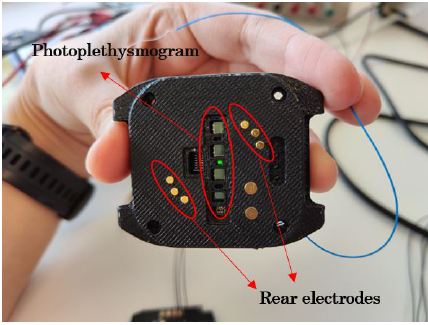
Figure 16. First prototype to validate feasibility.